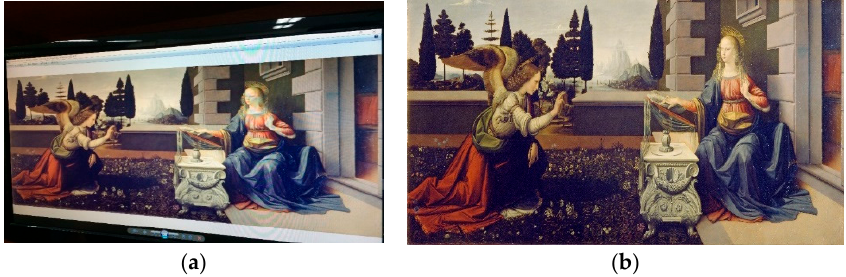
Figure 8. Original image and ordinary photograph of The Annunciation . ( a ) Ordinary photograph; ( b ) Original image.